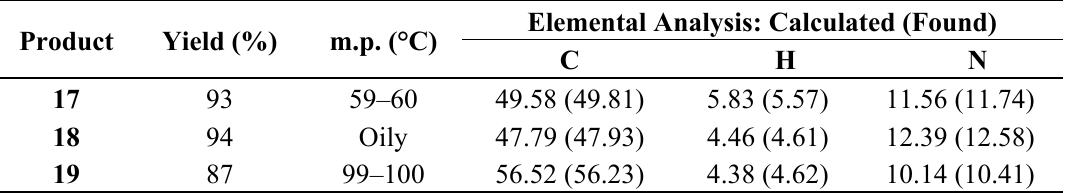
Table 2. Yield, m.p. and elemental analysis of the oximinocarbonate derivatives 17 – 19 .